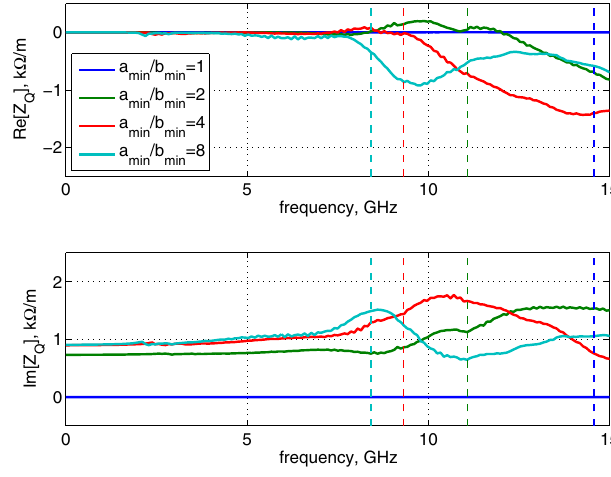
FIG. 6. (Color) Quadrupolar impedance (solid line) and cutoff frequencies of the structure (dashed line).